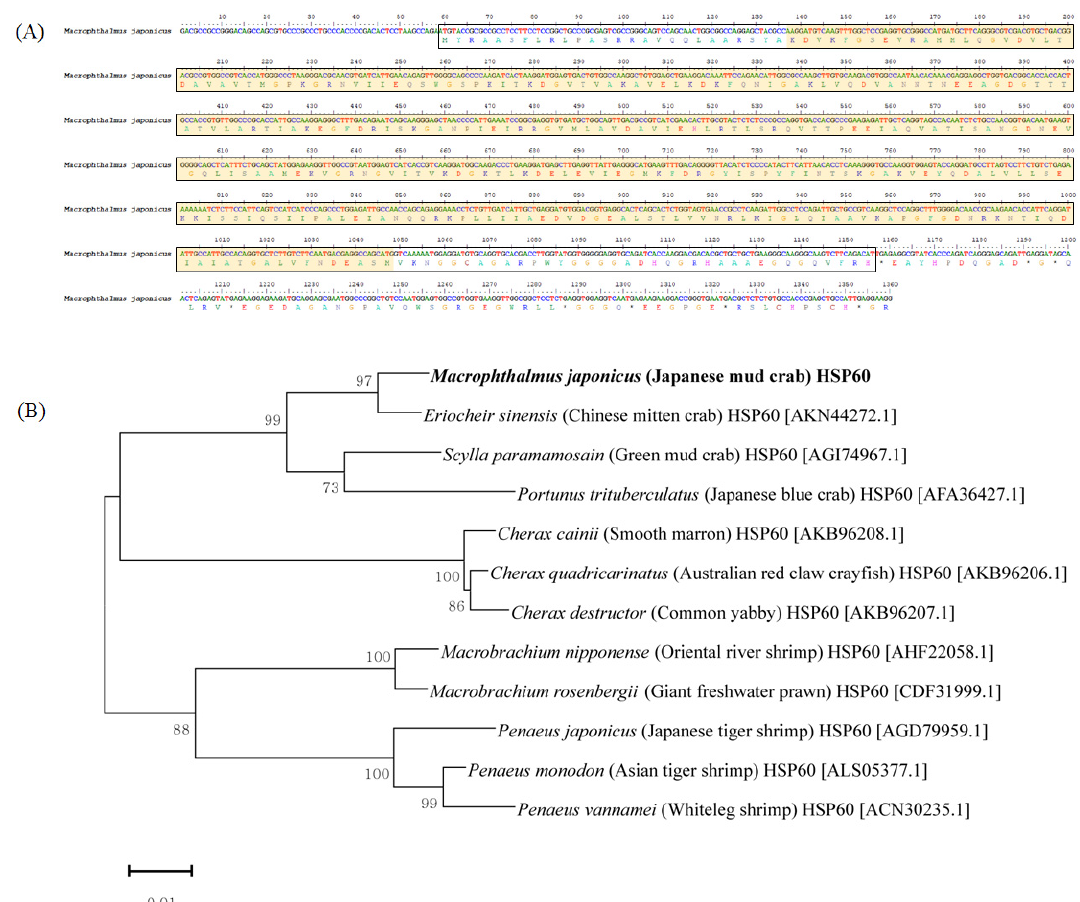
Figure 1. Genomic information of Macrophthalmus japonicus HSP60 sequences identified in this study. ( A ) Mj-HSP60 structure was represented using the BioEdit program (North Carolina State University,